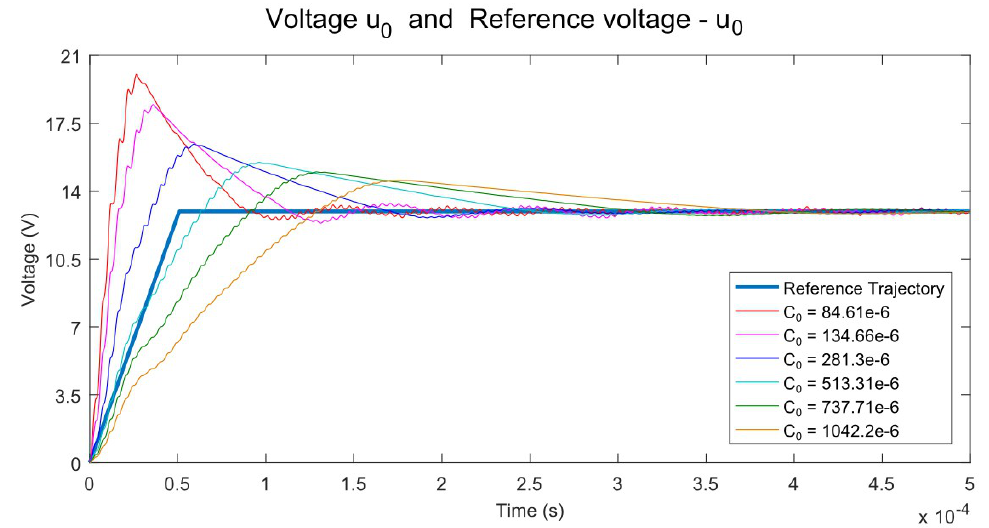
Figure 10. Optimization procedures for the output capacitor value.